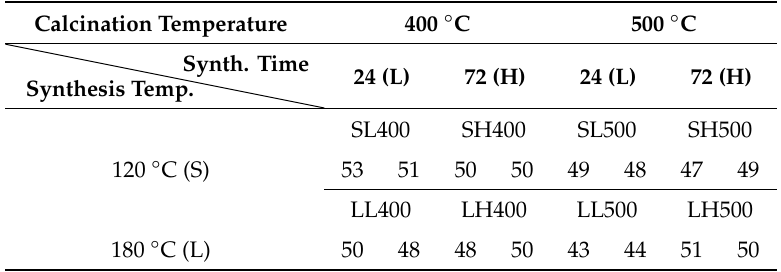
Table 2. Degradation percentage of K 3 [Fe(CN) 6 ] after 2 h of reaction, using a catalyst load of 0.5 g/L. Calcination Temperature 400 °C 500 °C Synth. Time Temp.Synth. 24 ( L ) Synthesis Temp.